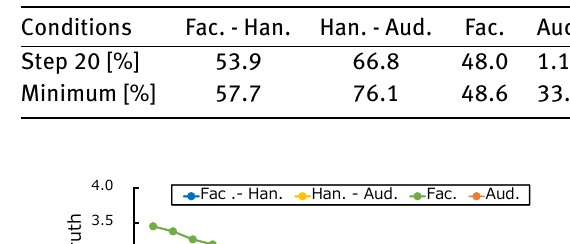
Table 1: Rate of change in distance between a ground truth and the 20th or closest point in the mental simulation.